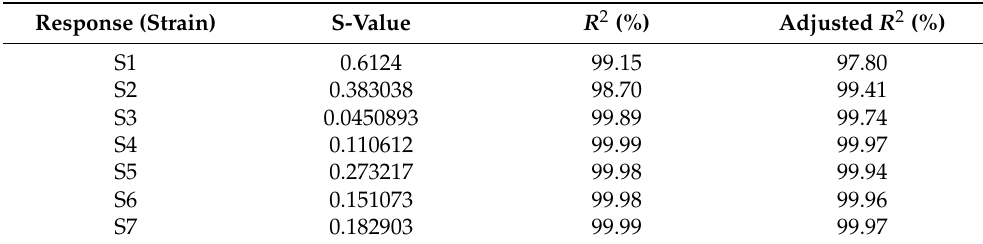
Table 5. Response-surface method model